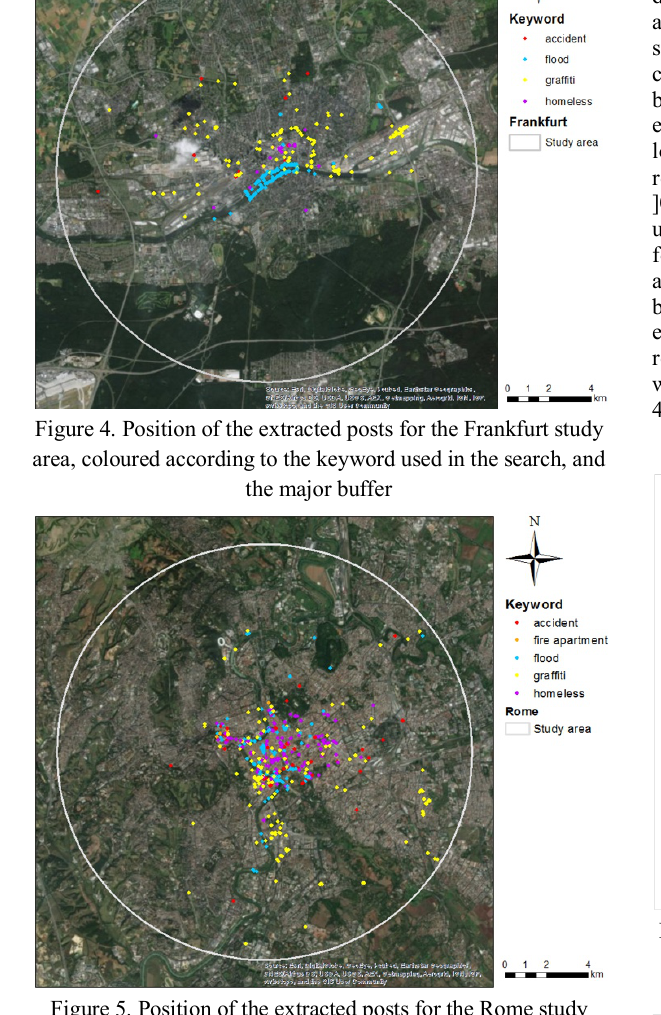
Figure 5. Position of the extracted posts for the Rome study area, coloured according to the keyword used in the search, and